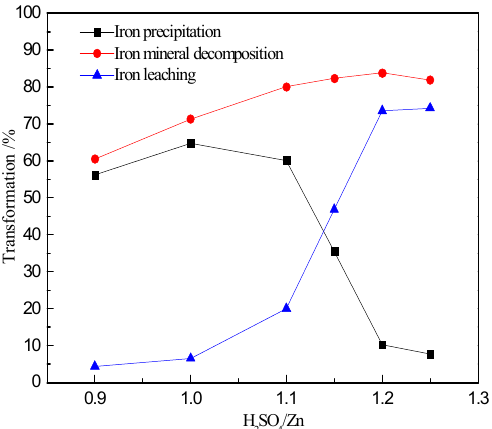
Figure 10. Relationship between extraction, iron decomposition and iron precipitation at various H 2 SO 4 /Zn ratios.